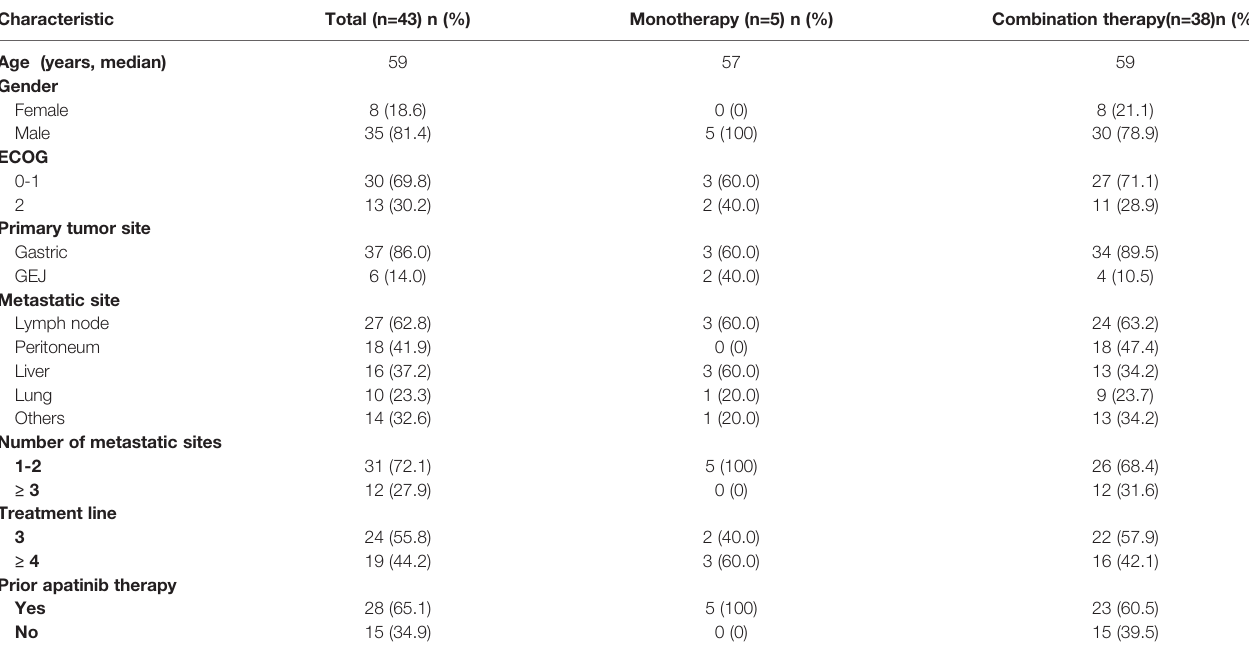
TABLE 1 | Patient and treatment characteristics.